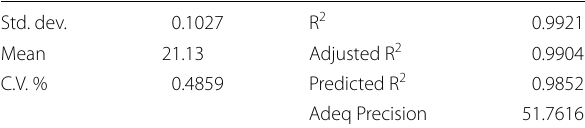
Table 8 Key results from ANOVA (Impact)